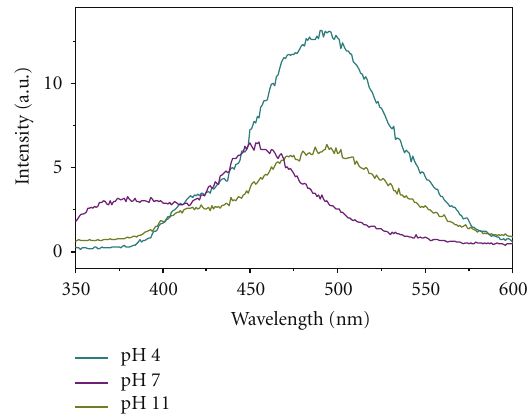
Figure 3: PL spectra of hydroxylated coumarin (7-hydroxycouma- rin) solutions adjusted at pH 4, 7, and 11. Each 1.0mM coumarin aqueous solution was mixed with 0.1g TiO 2 and irradiated therea- fter using an UV lamp with the peak intensity of 366nm for 15 min.